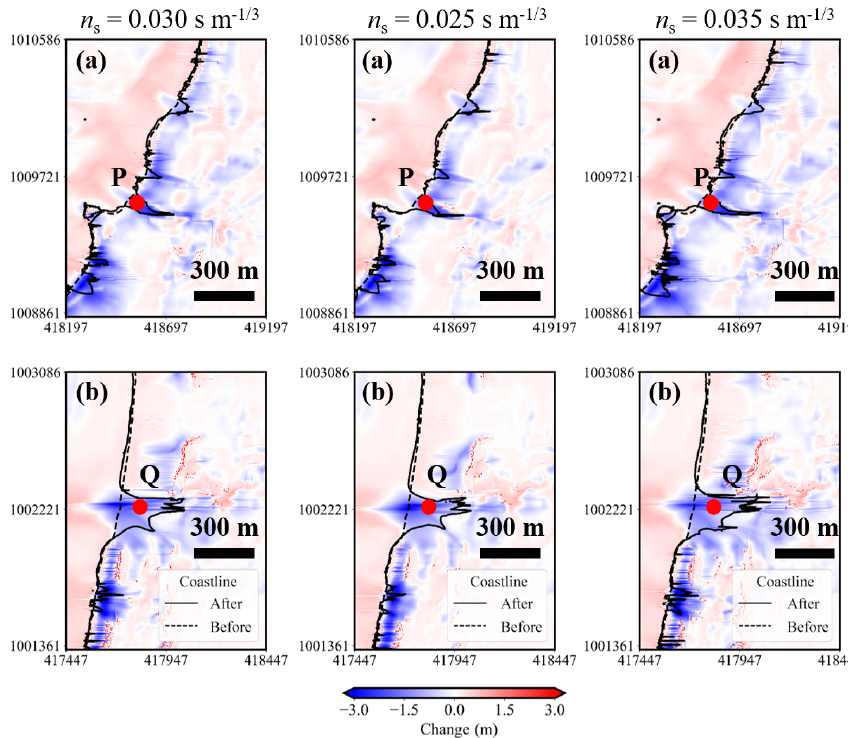
Figure 11. Topographic change and shoreline position caused by the tsunami for each roughness coefficient. Table 4. Volume of erosion and deposition in regions (a) and (b) for each roughness coefficient (percentage shows the ratio to